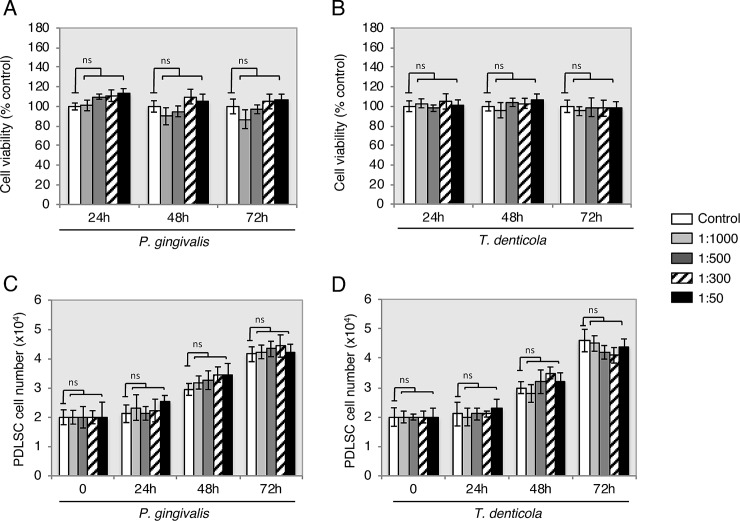
Viability and proliferation of PDLSC exposure to P. gingivalis and T. denticola.Upon supernatant treatment (untreated, 1:1000, 1:500, 1:300 and 1:50), PLDSC viability and proliferation percentages did not alter throughout periods of time (24 h, 48 h and 72 h) when compared with untreated controls (open columns). ns: non-significant. Data are shown as the mean ± S.D of 3 samples (3 wells each) from one representative experiment.